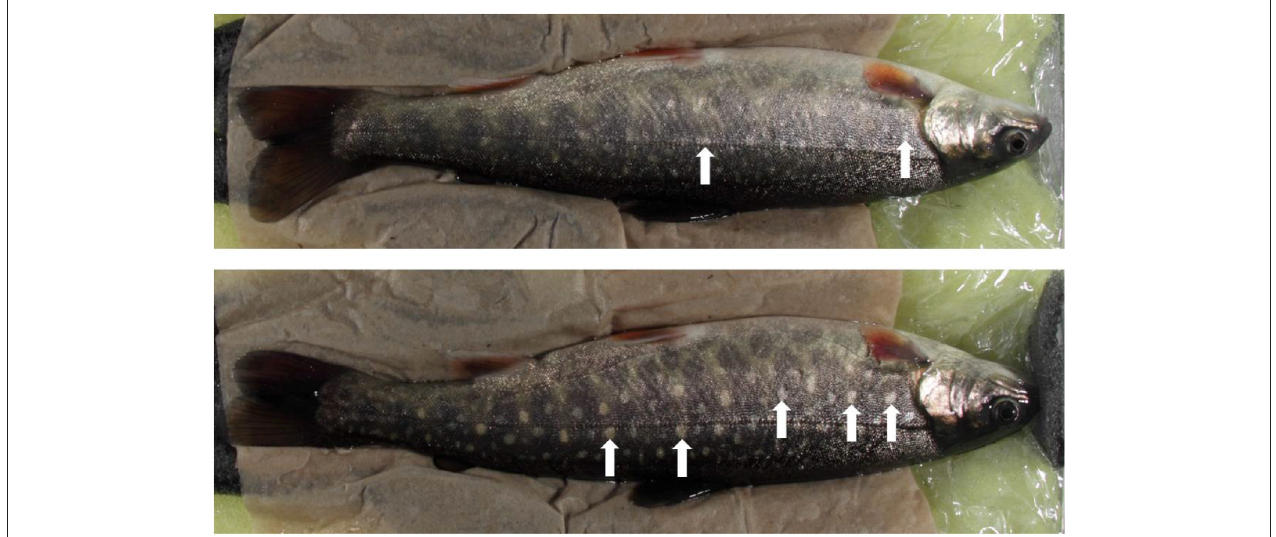
FIGURE 2 | Carotenoid pigmentation in Arctic charr. Two photographs depicting the difference between an Arctic charr with few carotenoid-based spots (upper charr) and an Arctic charr with many carotenoid-based spots (lower charr). The white arrows indicate typical spots. In this example, the upper charr with fewer spots would represent a dominant and more stress resilient individual compared to the lower charr, which is subordinate and more stress sensitive. Further, there are also correlations between spots and serotonin (see text for further